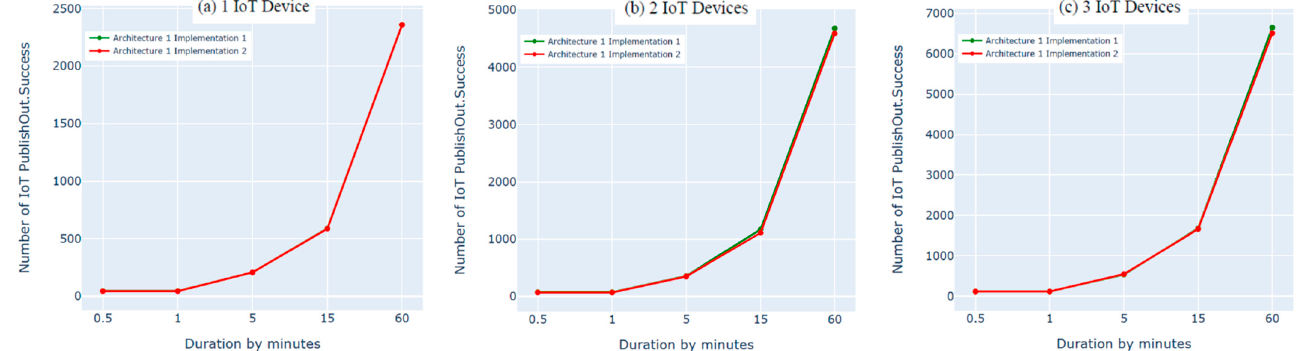
Figure 11. AWS IoT message broker PublishOut.Success metric with 1, 2, and 3 IoT devices on North Virginia datacenter (cloud layer).